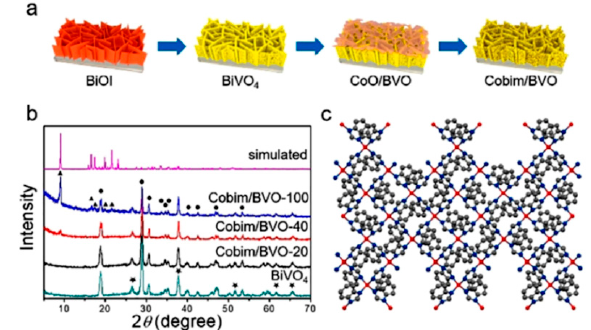
Figure 18. ( a ) Synthesis process of [Co 2 (bim) 4 ]-modified BiVO 4 photoanodes; ( b ) XRD patterns of BiVO 4 , Cobim/BiVO-20, Cobim/BiVO-40, Cobim/BiVO-100, and simulated [[Co 2 (bim) 4 ], where the symbols asterisk, dot, and triangle correspond to the peaks from FTO, BiVO 4 , and [Co 2 (bim) 4 ], respectively; ( c ) Crystal structure of [Co 2 (bim) 4 ], where gray, blue, and red balls represent carbon, nitrogen, and cobalt, respectively. Reprinted with permission from ref. [69]. Copyright 2018. American Chemical